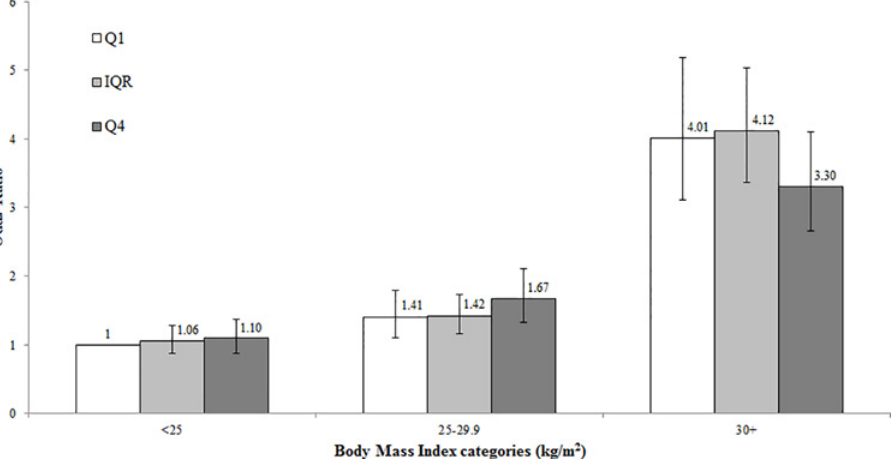
Fig 1. Endometrial Cancer Risk within BMI and BMI GRS Subgroups. Data represent odds ratios and 95% confidence intervals of endometrial cancer for quartile 1 (Q1; 67.5 – 87.1 risk alleles), the interquartile range (IQR; 87.2 – 95.5 risk alleles), and quartile 4 (Q4; 95.6 – 115.3 risk alleles) categories of the BMI GRS among normal weight ( < 25 kg/m 2 ), overweight (25 – 29.9 kg/m 2 ), and obese (30+ kg/m 2 )